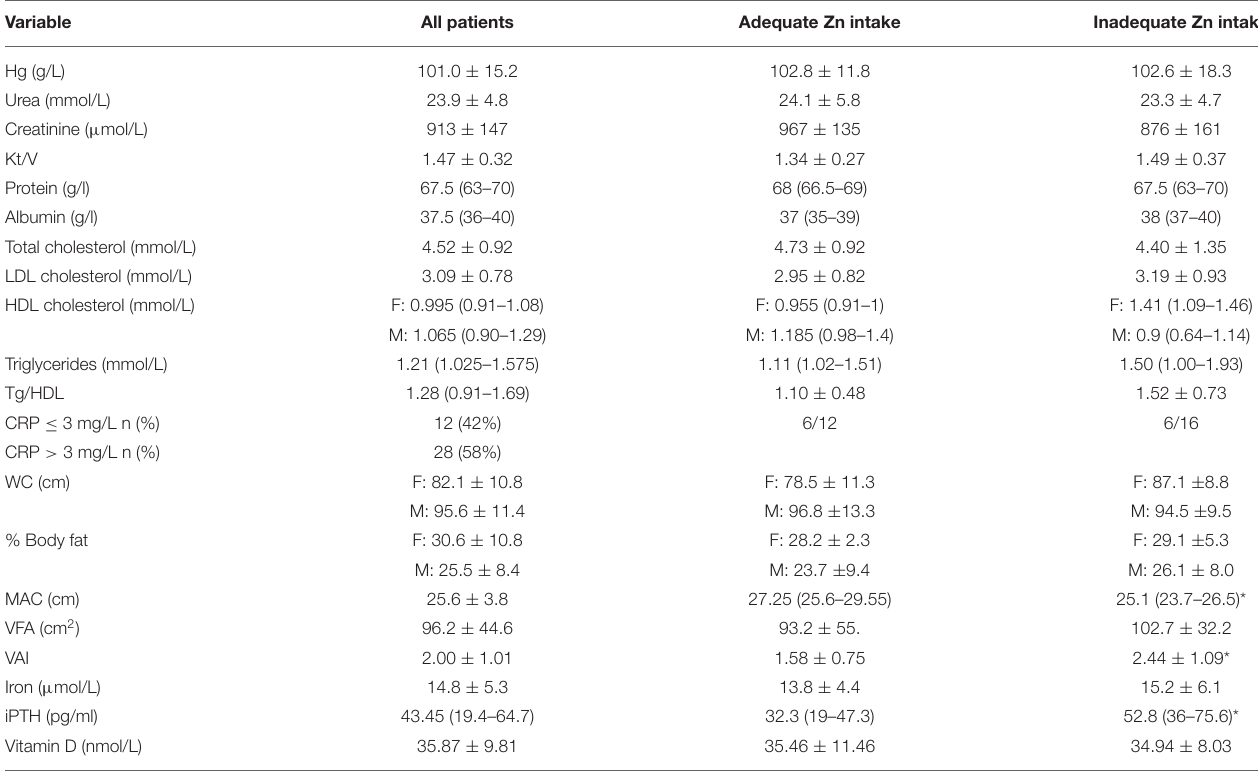
TABLE 2 | Characteristic of the hemodialysis patients. Variable All